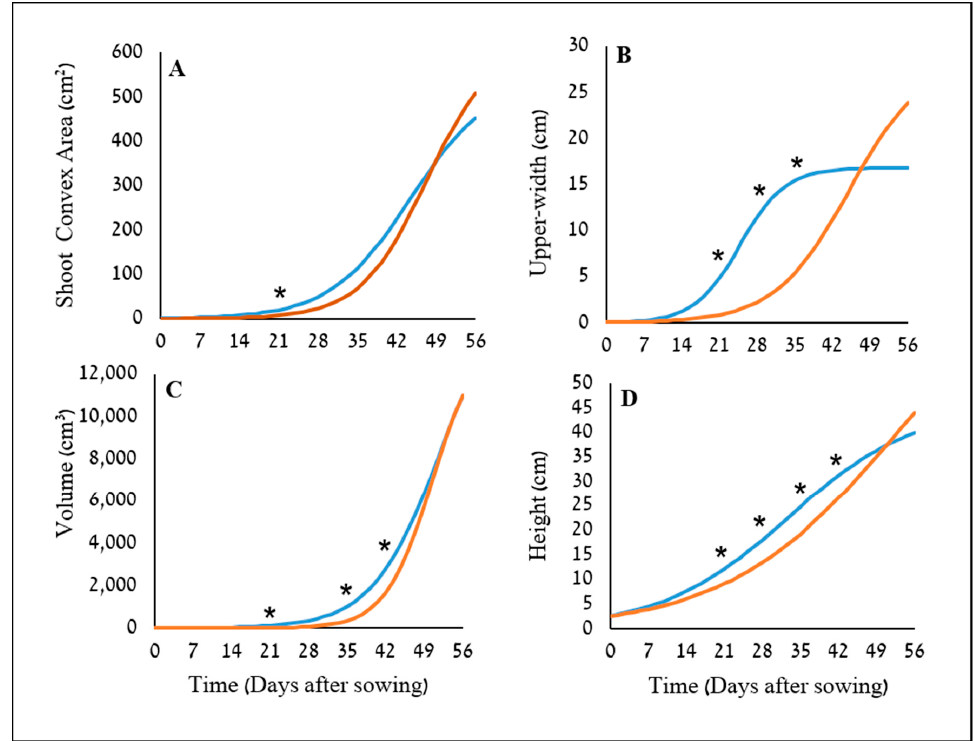
Figure 6. Sigmoid relationship between time (days after sowing) and X-1010 ( blue ) and Triticale1 ( orange ) genotypes ( A ) shoot convex area (SCA), ( B ) upper-width, ( C ) volume, and ( D ) height values that were extracted from the 3-D model. * indicate a significantly difference between X-1010 and Triticale1 ( p ≤ 0.05) according to t -test ( n = 6).